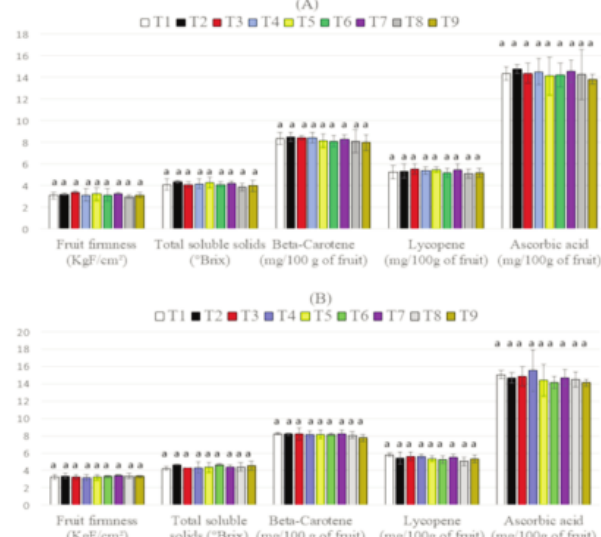
Fig. 4 ­ Fruit quality parameters of tomato cv. Roma under diffe­ rent treatment against Tuta absoluta in trials one (A) and two (B). T1: Steinernema sp. RW14­M­C2a­3, T2: Steinernema sp. RW14­M­C2b­1, T3: Metatech®WP (Metarhizium anisopliae, Strain FCM Ar 23B3), T4: Beauvitech® WP (Beauveria bassiana, Strain J25), T5: Tephrosia vogelii, T6: Phytolacca dodecandra, T7: azadi­ rachtin 0.03% EC, T8: imidacloprid, T9: Water; Similar let­ ters above the bars indicate non­significant difference according to Tukey’s test